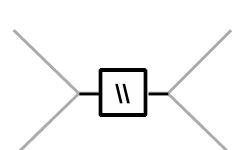
Figure 2.29: The Process Description glyph for omitted process .